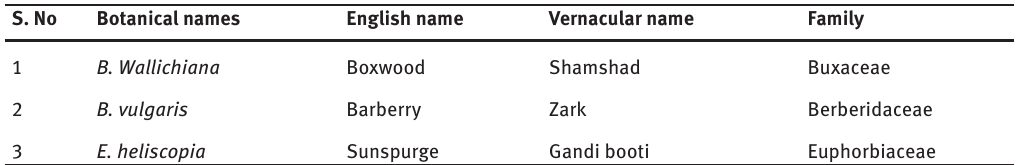
Table 1: Selected medicinal plants for antiprotoscolices effect against E. granulosus. S.